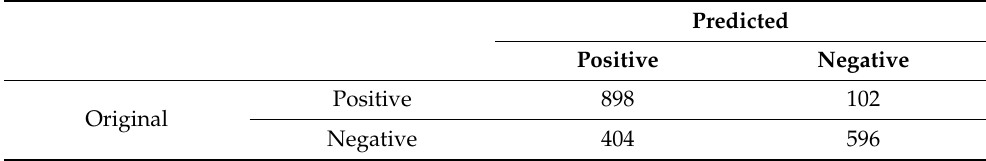
Table 11. Confusion matrix for lexicon baseline approach.